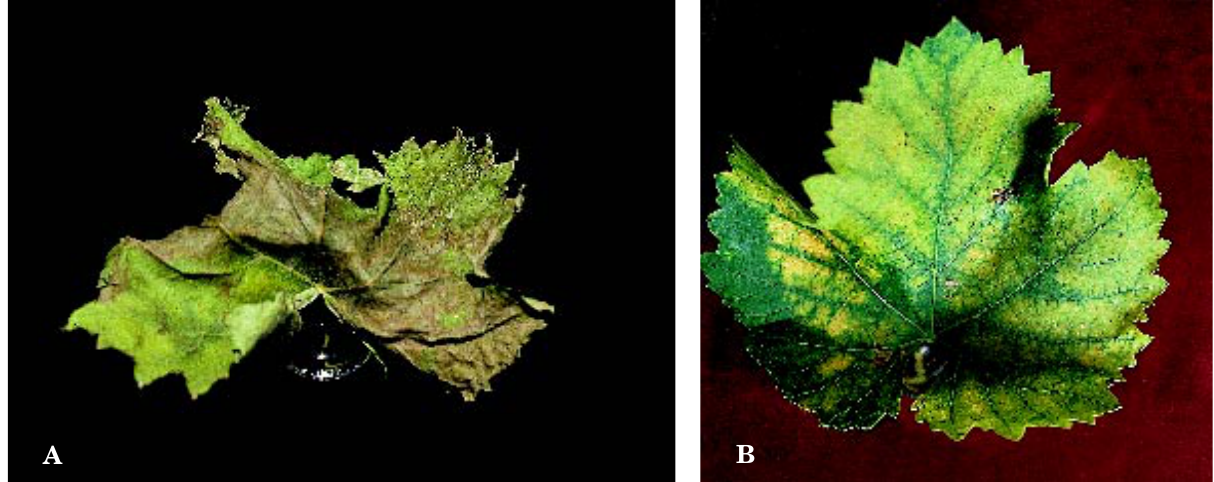
Fig. 2. Effect of the absorption for a few hours of 3 ml of 0.05 mg ml -1 scytalone (A) or 0.1 mg ml -1 isosclerone (B) on detached leaves of grapevine cv.